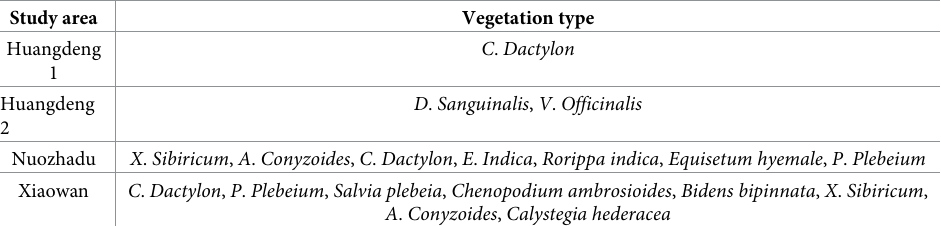
Table 1. Vegetation types of each study